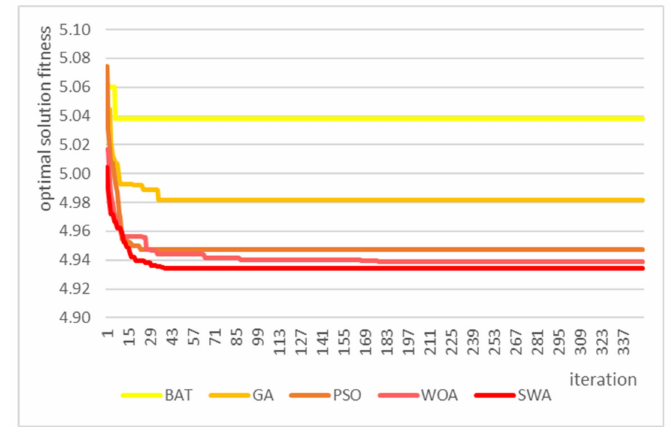
Figure 15. The fitness of the optimal solution found by the metaheuristic algorithms after 360 iterations, for the IEEE 33-bus